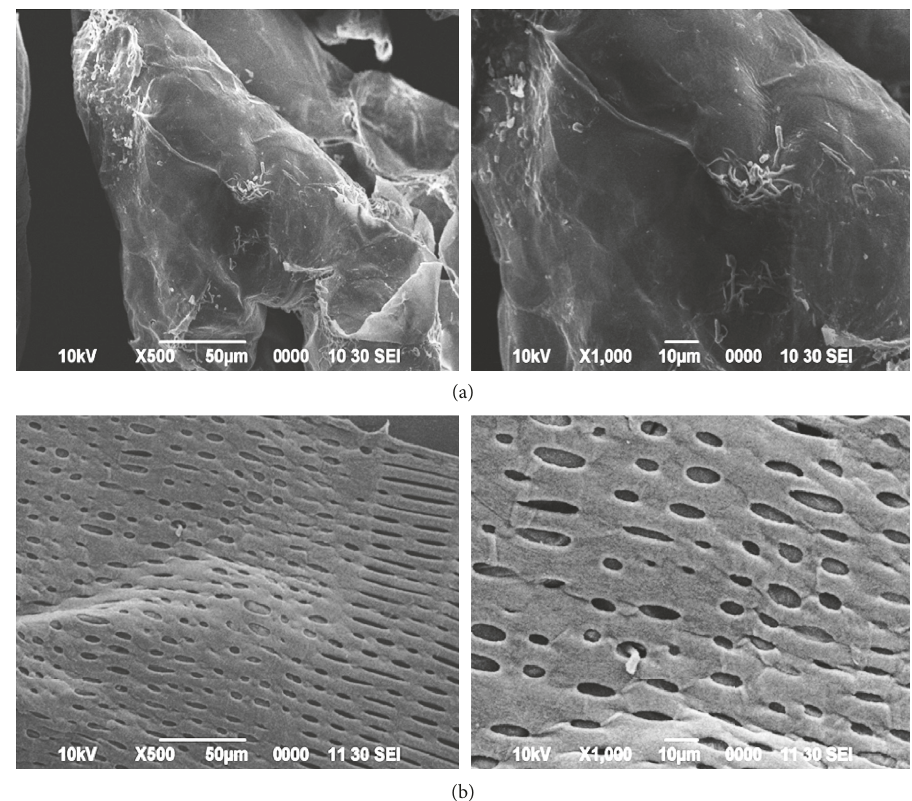
Figure 1: (a) 500x and 1000x magnified unmodified sago hampas. (b) 500x and 1000x magnified modified sago hampas.